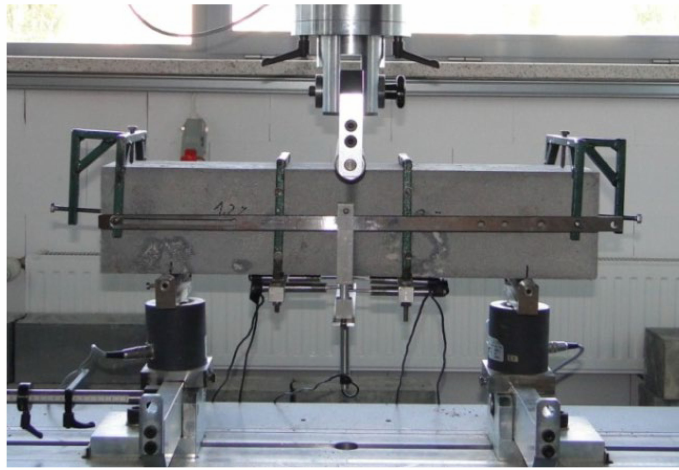
Figure 4. A sample on the fiber composite residual strength test